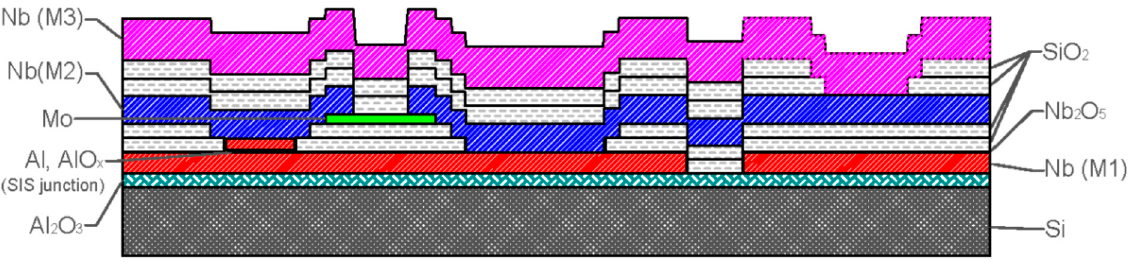
Figure 1. Schematic representation of a Nb-based low-T c Josephson junction developed at IRE.